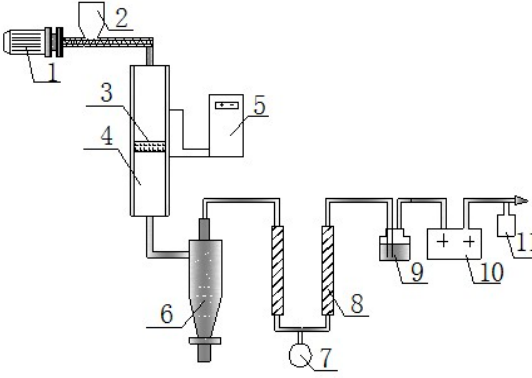
Figure 1. Flowchart of experimental apparatus. (1—motor; 2—hopper; 3—porous ceramic; 4—fixed bed pyrolyzer; 5—temperature controller; 6—cyclone; 7—flask; 8—condenser; 9—silica meter; 10—gas meter; 11—gas sample bag) .